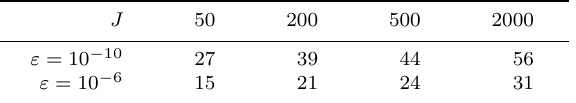
Figure 3 corresponds to the variant of the 5-point solver and the 9-point FD scheme. In Figure 4, graphics of the discrepancy function − ln( d ) in dependence on s/ ln( J ) are shown for the case of Figure